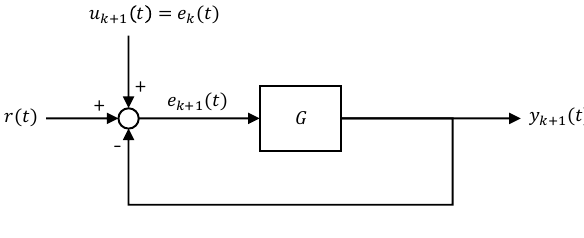
Figure 1: Basic mechanism of an ILC